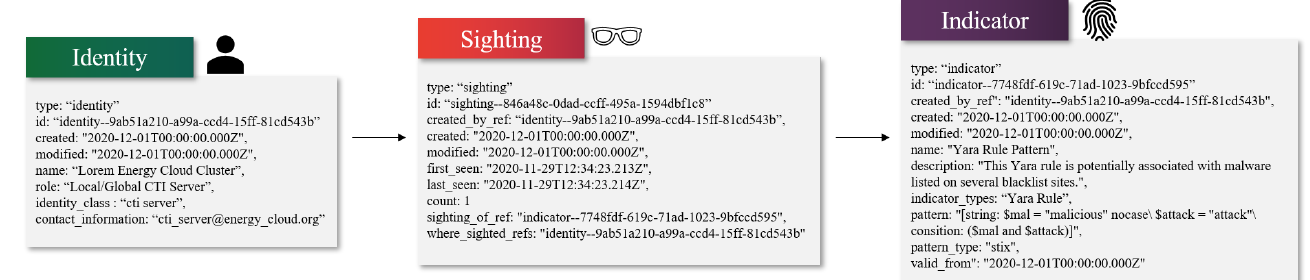
Figure 4. Examples of scenarios for forming CTI security policy.